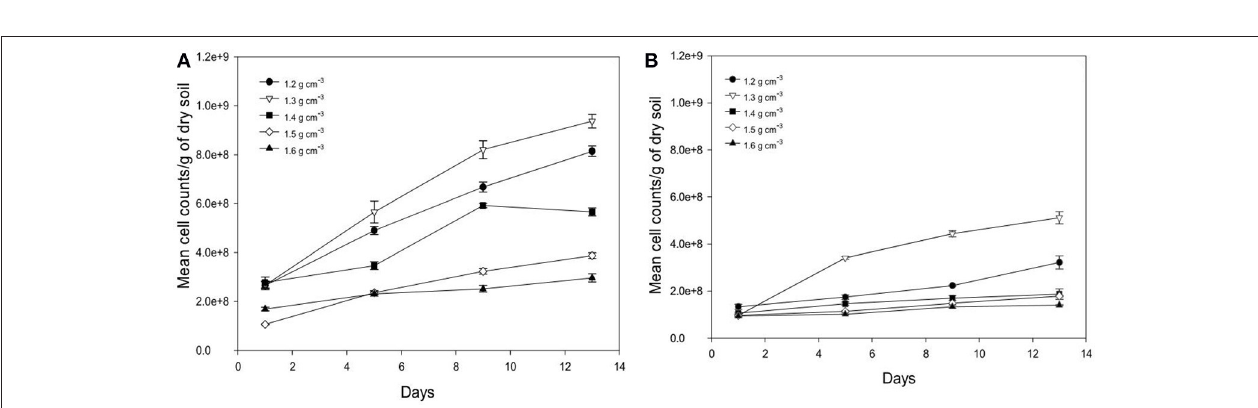
FIGURE 5 | Change in number of cell counts per gram soil with time after inoculation with P. fluorescens (A) and B. subtilis (B) in soil at bulk densities of 1.2g cm − 3 (•),1.3g cm − 3 ( ▽ ),1.4g cm − 3 ( (cid:4) ), 1.5g cm − 3 ( ♦ ), and 1.6g cm − 3 ( N ). Data are means ± SE ( n = 3).